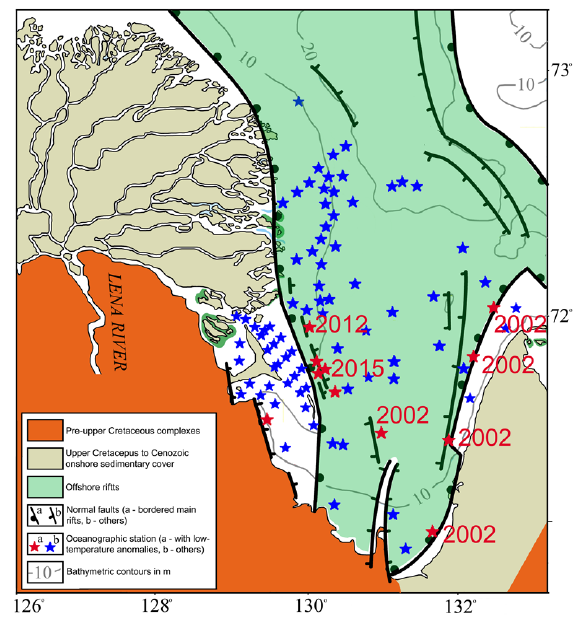
Figure 3. Ust’ Lena graben (after Drachev et al., 1998; Franke et al., 2001; Imaev et al., 2004). Numbers above the red stars indicate the years in which the studies were carried